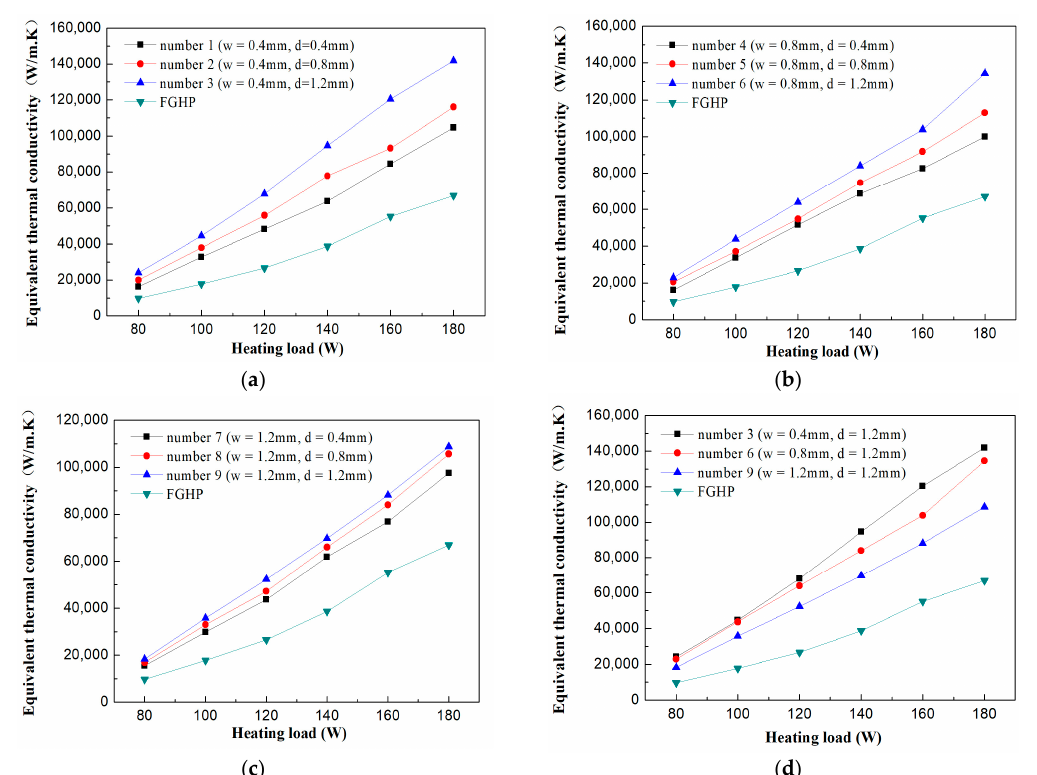
Figure 6. The equivalent thermal conductivity of the FMGHPs and FGHP at different heating loads: ( a ) FMGHPs 1–3 and FGHP; ( b ) FMGHPs 4–6 and FGHP; ( c ) FMGHPs 7–9 and FGHP; ( d ) FMGHPs 3, 6, 9 and FGHP.